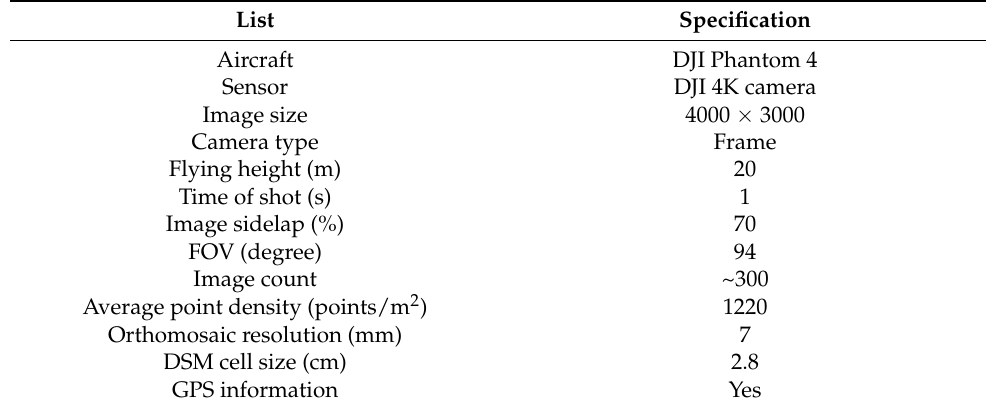
Table 1. The specifications of the drones and the cameras.